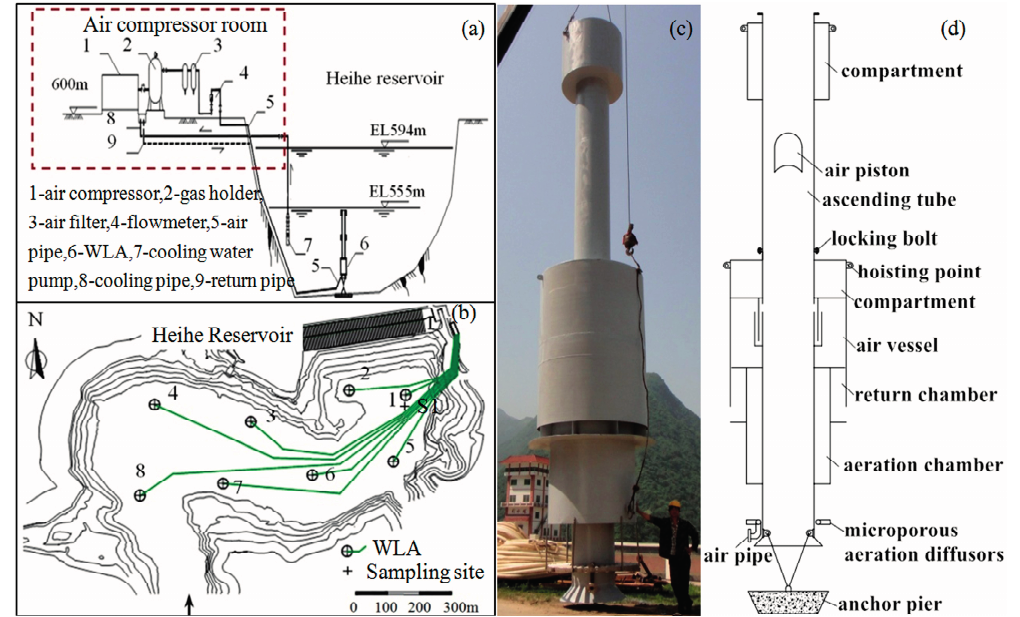
Figure 2. The water-lifting and aeration system: Flow chart of the water-lifting and aeration system ( a ); layout of the water-lifting aerators in Heihe Reservoir ( b ); the photo of the assembled water-lifting aerator ( c ) and the diagram of the water-lifting aerator structure ( d ). Daily hydrological and climate data, i.e. , reservoir water levels, water inflow, water discharge and watershed precipitation during the investigation period were obtained from measurements by the Heihe Reservoir hydrological station adjacent to the